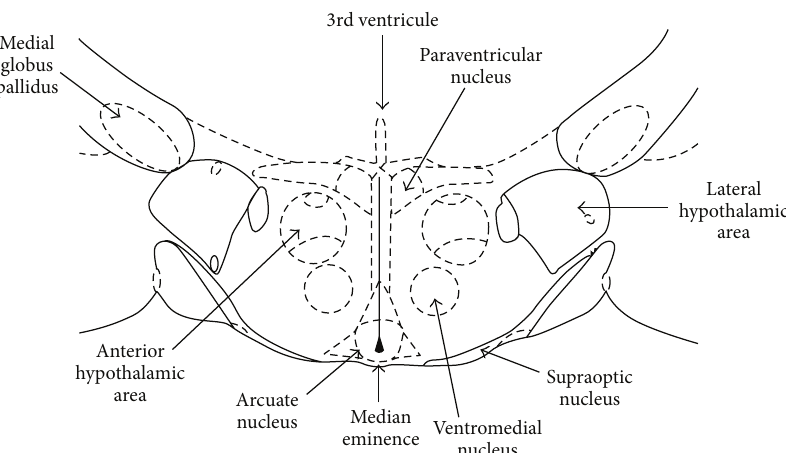
Figure 1: Overview of the major hypothalamic nuclei producing neuropeptides. Paraventricular and supraoptic nuclei contain neurons producing corticotrophin-releasing hormone, urocortins, thyrotropin releasing hormone, oxytocin, and vasopressin. Ventromedial nucleus neurons produce Substance P, enkephalins, and Neuropeptide Y. Arcuate nucleus neurons express agouti-related peptide, Neuropeptide Y, proopiomelanocortin, melanocyte-stimulating hormones, adrenocorticotropic hormone-stimulating hormone, and endorphins (modified according to Paxinos and Watson, 1997